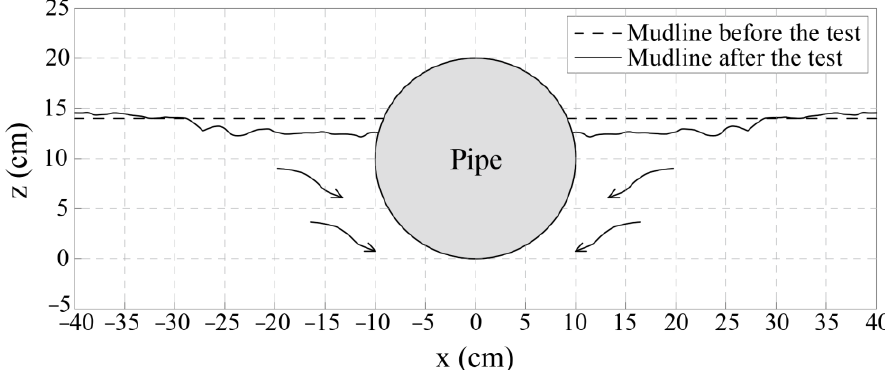
Figure 11. Soil deformation and mudline subsidence after dissipation of excess pore pressure in Test 5. The arrows show the soil was compressed after soil liquefaction and pore water dissipation.